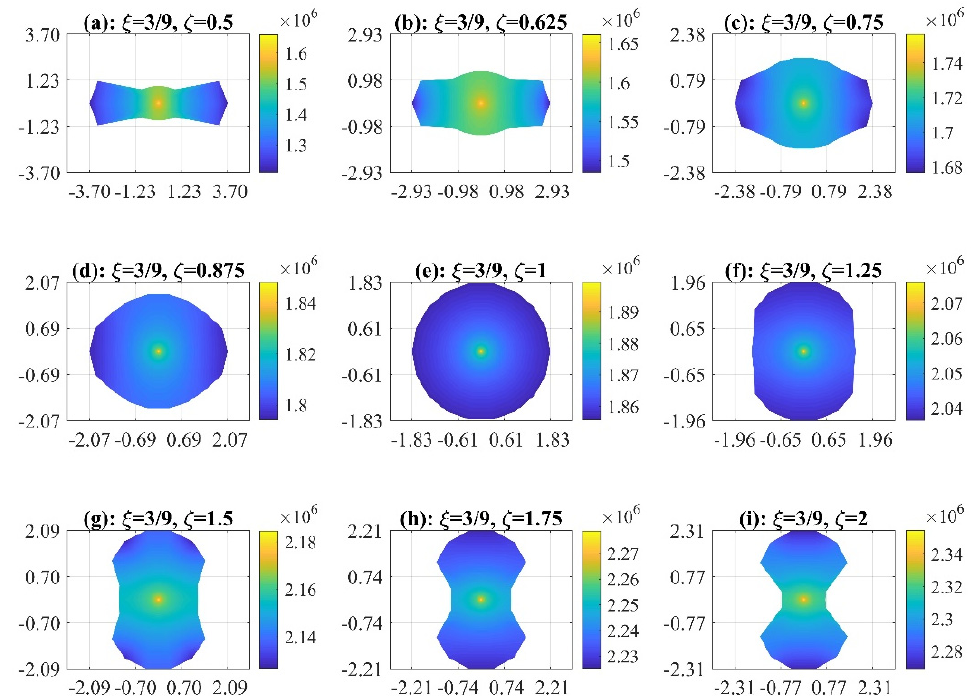
Figure 7. Distributions of fluid pressure of Group 2 numerical experiments ( ξ = 3/9) with 9 different fracture toughness contrasts at the moment = 20s.